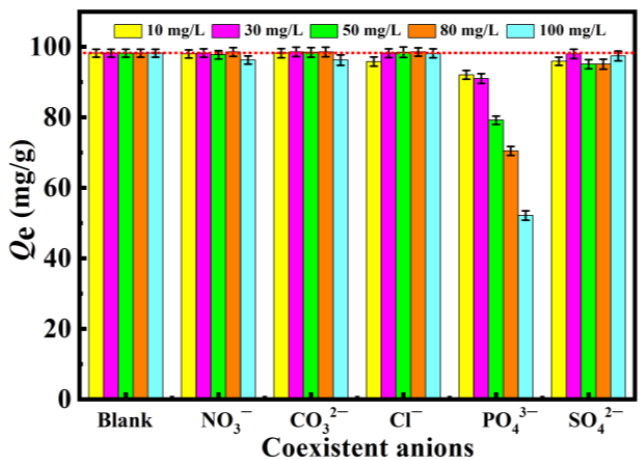
Figure 7. Effect of interfering anions on the fluoride adsorption density by using LMF11 NFs.